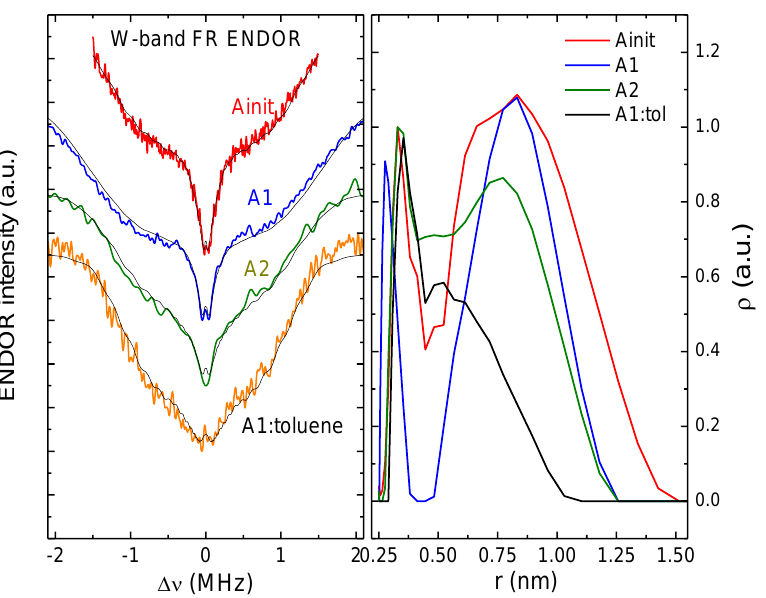
Figure 9. (Left panel) ENDOR spectra for FR in the W-band for the asphaltenes subfractions and A1 dissolved in deuterated toluene (v:v = 1:20); (right panel) distribution function of the contribution of protons from the distance to FR, obtained from the ENDOR spectra.